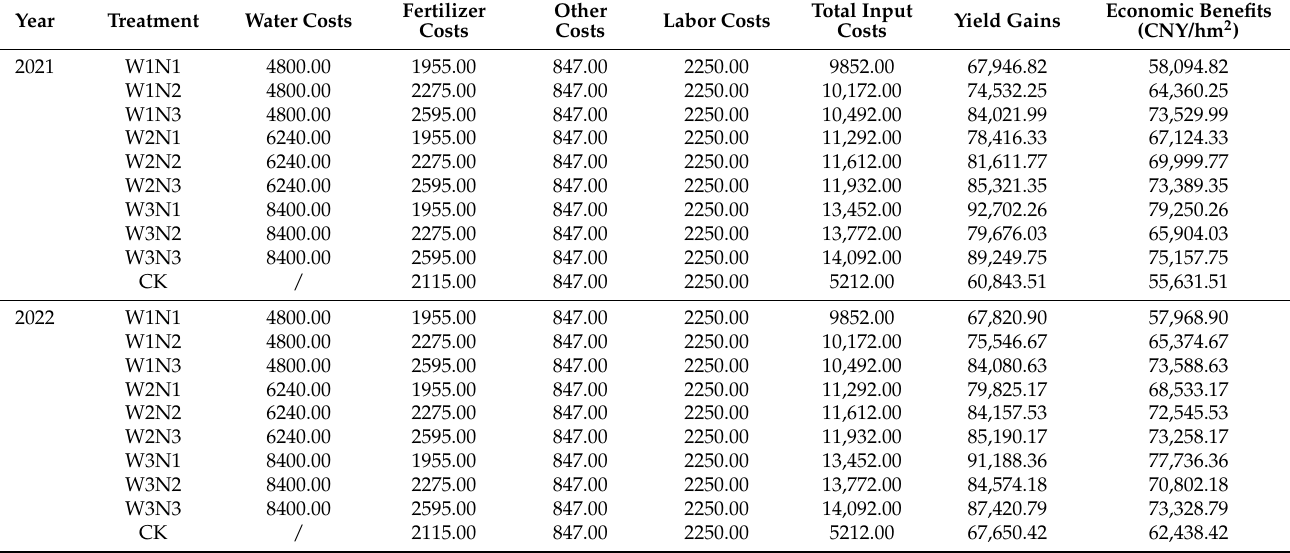
Table 3. Effect of water and nitrogen regulation on economic